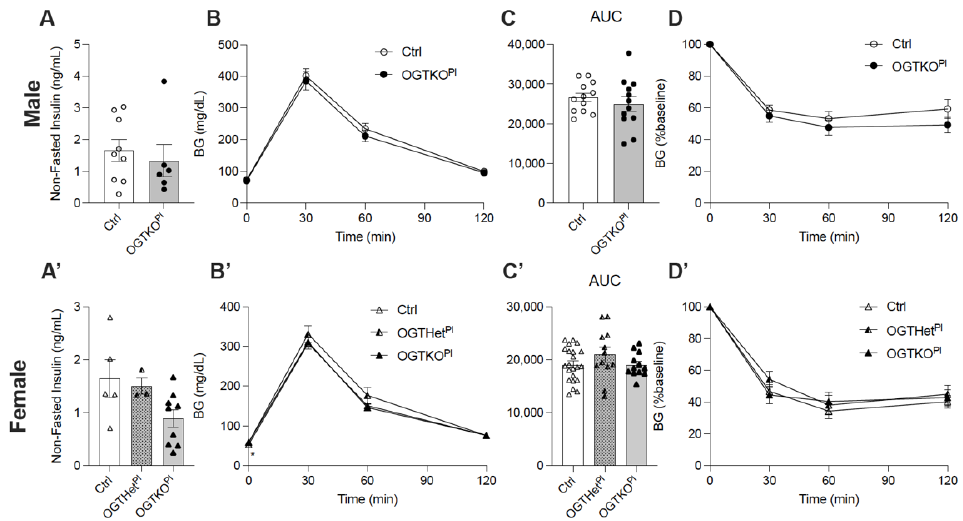
Figure 1. Reduced placental OGT in female offspring on normal chow had an increase in fasting BG. ( A ) Non-fasted insulin at 12 weeks of normal chow for male mice (n = 5, 7). ( A’ ) Non-fasted insulin of female mice at 12 weeks of NC (n = 3, 9). ( B ) IPGTT and ( C ) calculated AUC for male (n = 12) and ( B’ , C’ ) female mice (n = 12, 22) at 6 weeks on normal chow. ( D ) ITT at 8 weeks on normal chow for male (n = 13, 14) and ( D’ ) females (n = 12, 18). Blood glucose values post insulin injection are expressed as a percent of baseline blood glucose. ( A , C ) were presented as mean ± SEM, unpaired t -test for males and one-way ANOVA for females. ( B , D ) were presented as mean ± SEM, two-way ANOVA. p values, * p < 0.05.